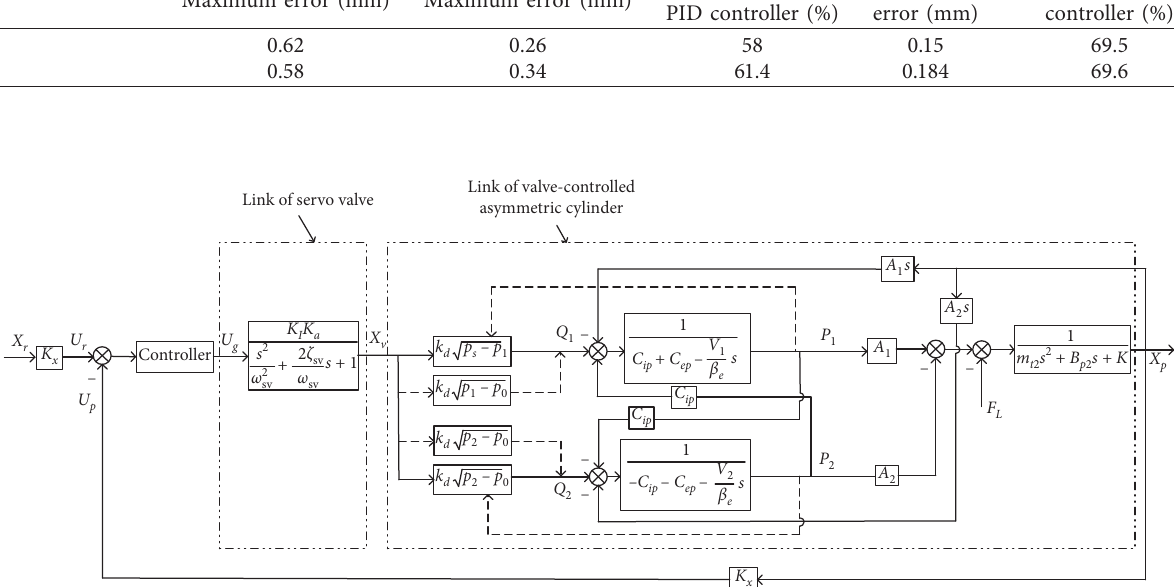
Figure 16: HDU position control block diagram.